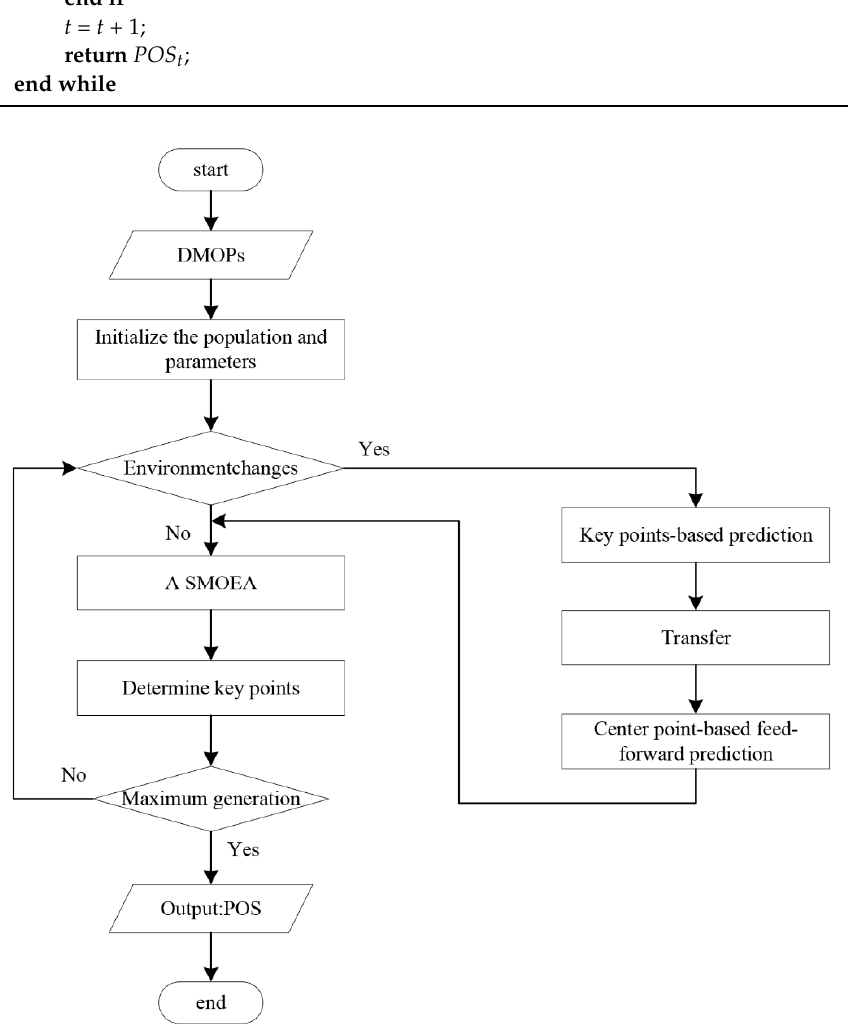
Figure 1. Procedure of KPTHP.